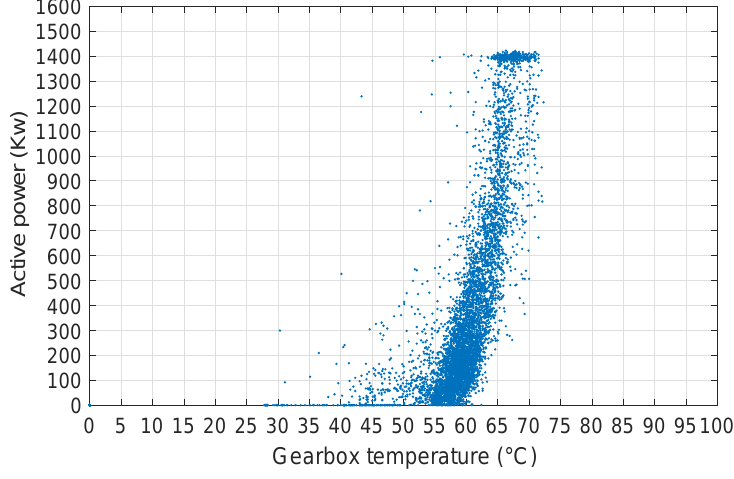
Figure 3. Gearbox bearing temperature–power scatter